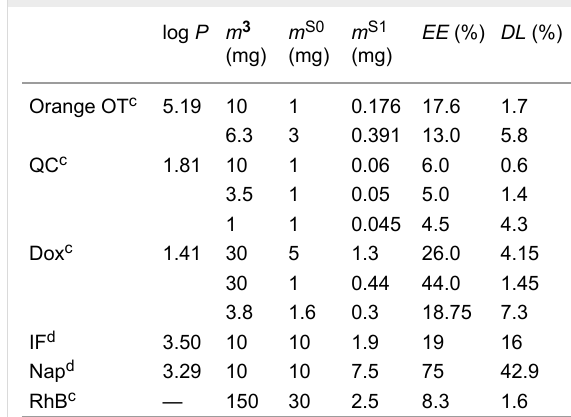
Table 2: Data of substrate encapsulation in micelles of 3 ; log P a : octanol–water partition coefficient of the substrates; m 3 : mass of 3 (mg); m S0 : initial mass of the substrate (mg); m S1 : mass of solubilized substrate (mg); EE : encapsulation ef fi ciency value (%) b ; DL : drug- loading value (%) b